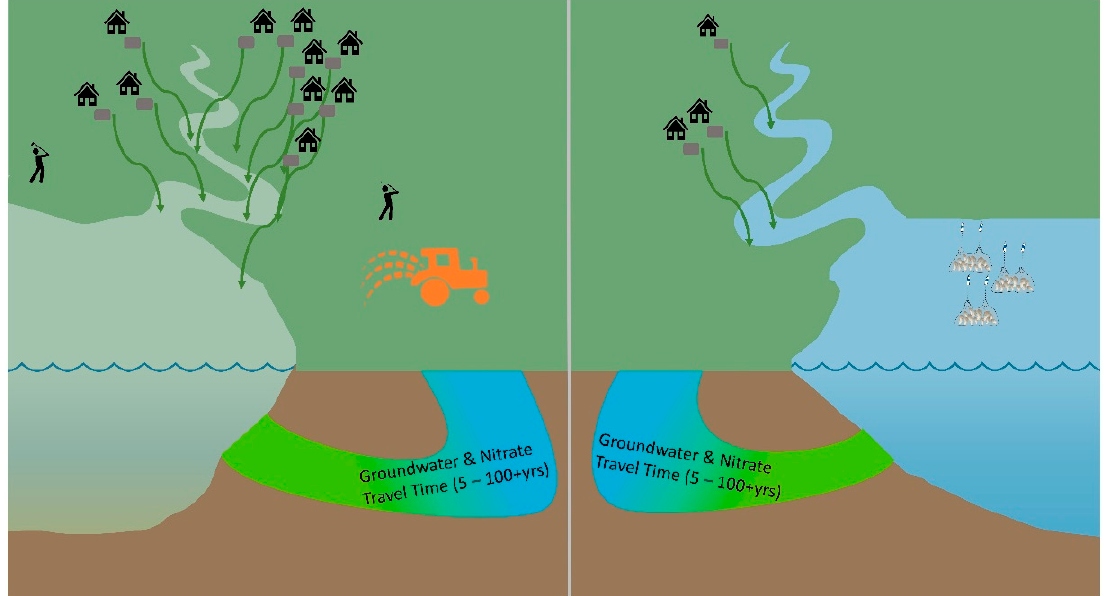
Figure 1. Nitrogen loading and processing in estuaries on Cape Cod, Massachusetts, USA. N loads